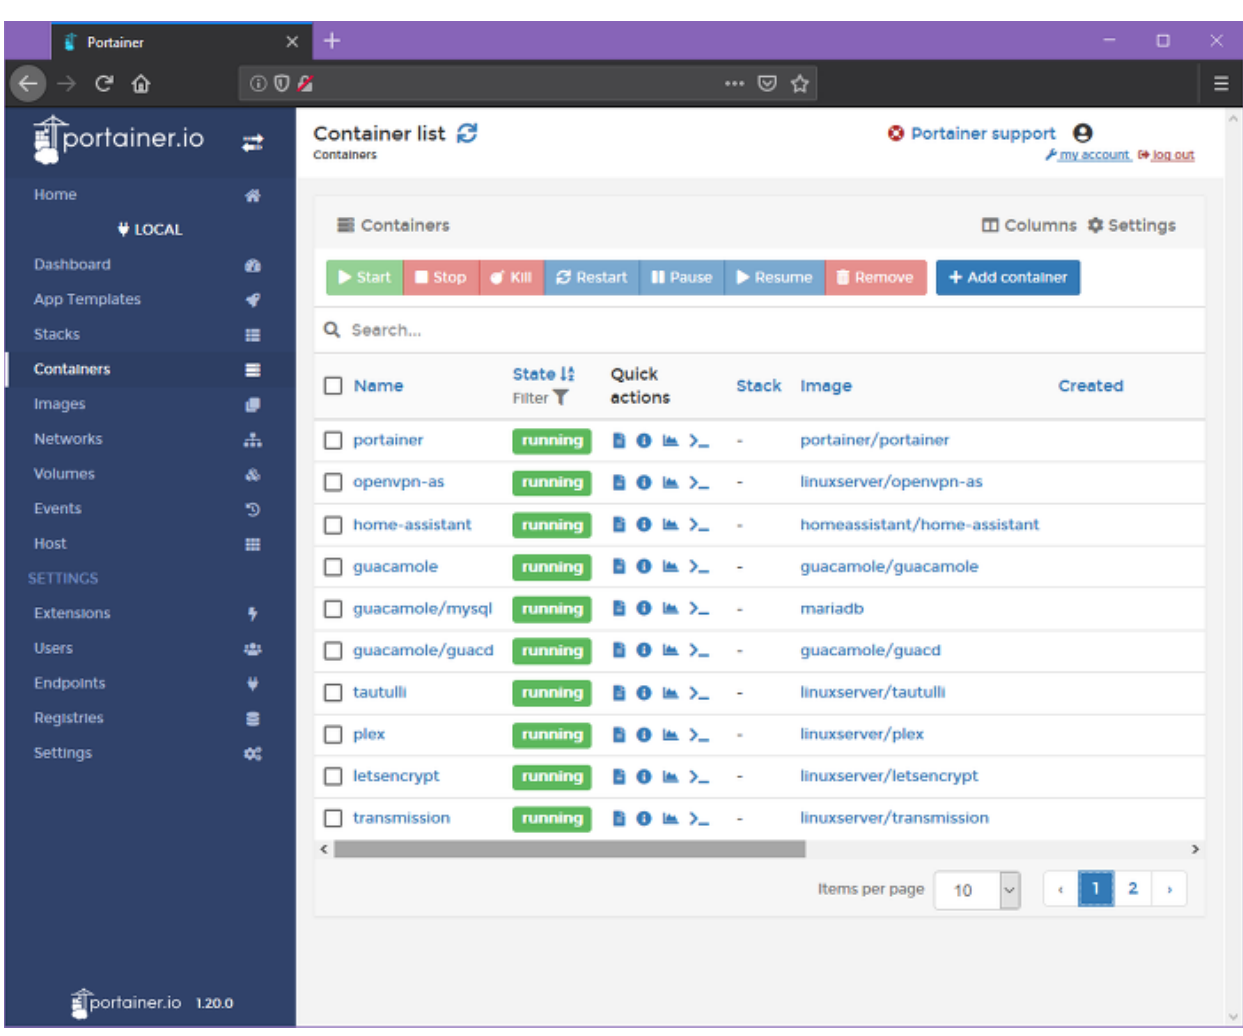
Figure 2. Portainer GUI for Docker container